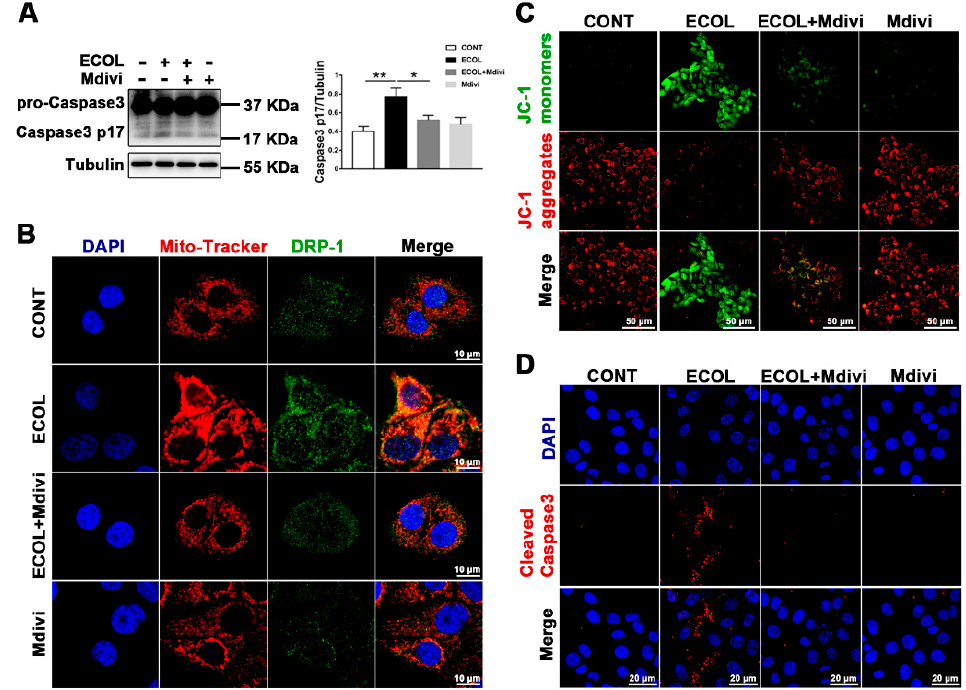
Figure 2. E. coli (EPEC) mediates DRP-1-dependent apoptosis. ( A ) The caspase-3 level was analyzed by Western blot. ( B ) DRP-1 translocated to mitochondria. Cells were stained with anti-DRP-1 (green), mitochondria (Mito-Tracker, red), and DAPI (Blue, nucleus). Scale bar, 10 µ m. ( C ) JC-1 was used to analyze the MMP. JC-1 monomers, green. JC-1 aggregates, red. Scale bar, 50 µ m. ( D ) Cleaved caspase-3 (red) immunofluorescence staining was used to observe apoptosis. DAPI (blue, nucleus); scale bar, 20 µ m. MAC-T cells were pre-treated with Mdivi (10 µ M) for 4 h, washed with PBS (3 times) to remove inhibitor, and exposed to E. coli (EPEC, MOI = 66) for 8 h. Representative images are shown. Data are from 3 independent experiments and presented as the mean ± SEM; * p < 0.05, ** p < 0.01.